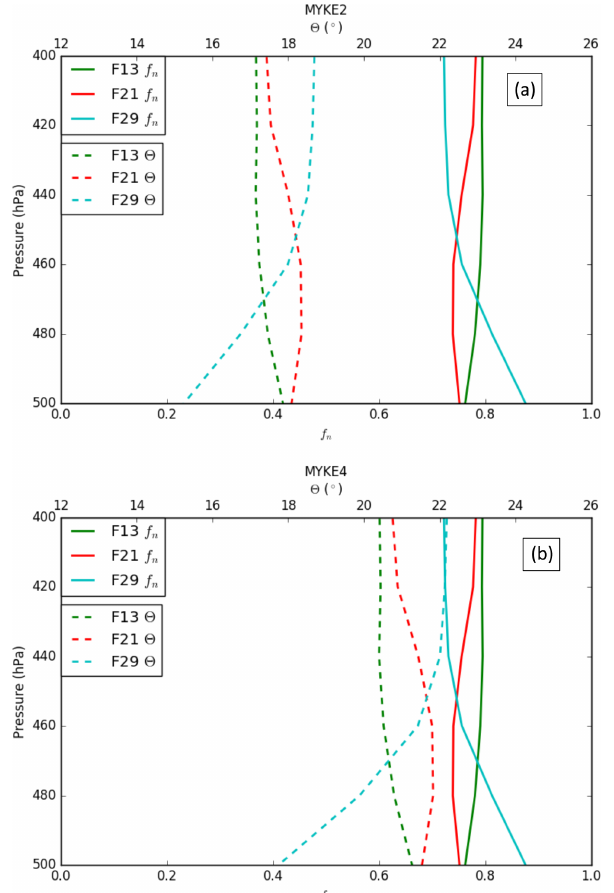
Figure 5. Vertical profiles of the neutralization fraction ( f n , full line) and the contact angle ( θ , dashed line) for MYKE2 (a) and MYKE4 (b) along flights F13 (green), F21 (red) and F29 (light blue).